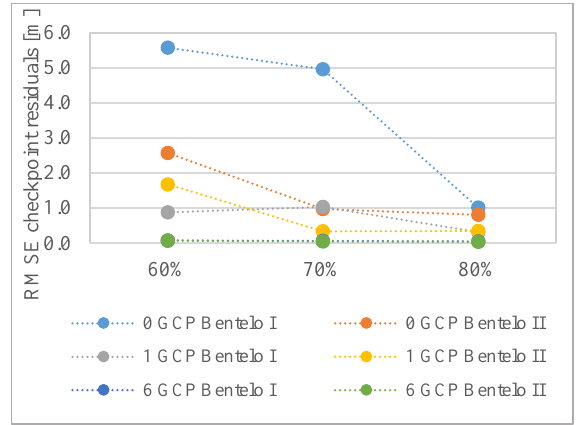
Figure 4: Effect of different side lap configurations on final RMSE of dataset Bentelo I and Bentelo II processed with